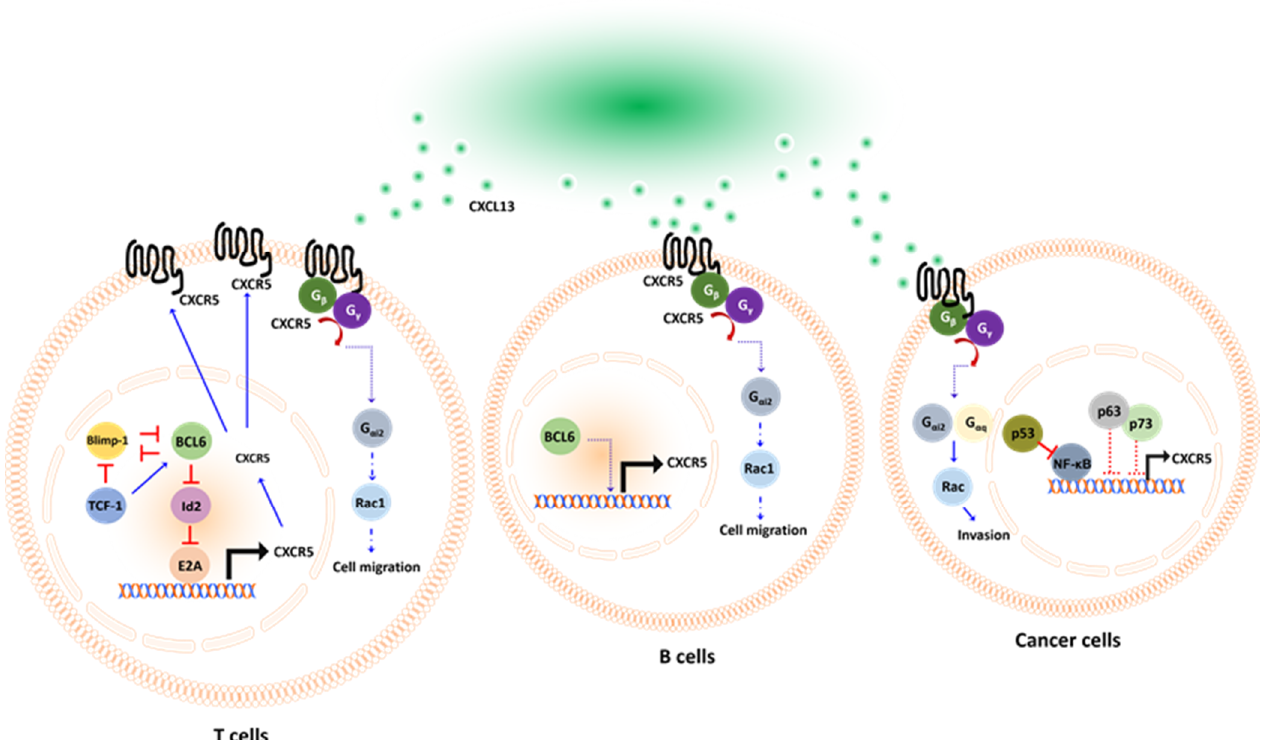
Figure 1. Schematic representation of CXCL13/CXCR5 axis in T cells, B cells, and cancer cells, respectively. CXCL13 acts as a ligand that specifically binds to its receptor CXCR5. Upon activation, the GDP bound G α protein subunit is replaced with a GTP molecule. This leads to the dissociation of G αq or G αi2 from the G β –G γ dimer, mediating downstream signal activation. CXCL13 promotes chemotaxis in T cells and B cells. However, in cancer cells, CXCL13 promotes migration and invasion. The transcriptional factors involved in CXCR5 expression are diverse in T or B cells and cancer cells. In T cells, BCL6 regulates the CXCR5 expression via a repressor of repressor circuit. While in cancer cells, p53 regulates CXCR5 indirectly by suppressing NF- κ